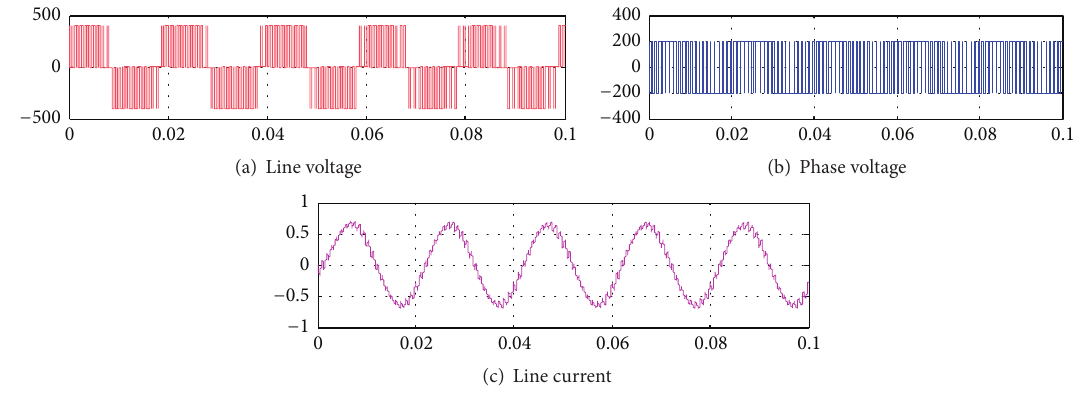
Figure 10: Five-level inverter as two-level